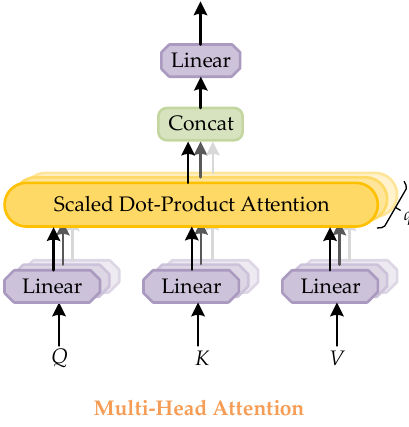
Figure 5. Structure of the multi-head attention module. It consists of several attention layers running in parallel. The symbol q represents the number of attention layers. Each layer takes scaled dot- product